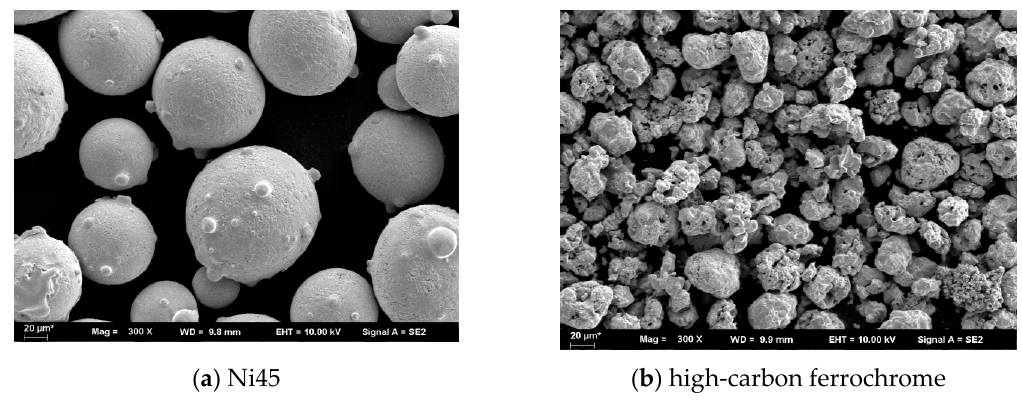
Figure 1. SEM Morphologies of the powders used for laser